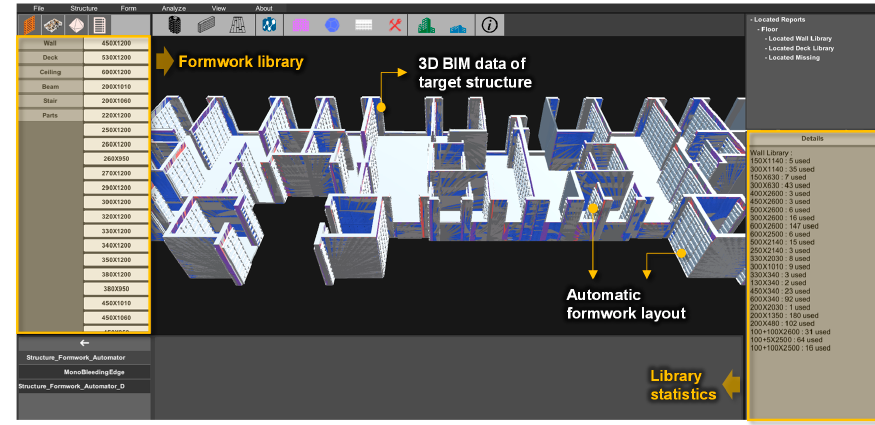
Figure 1. Operational image of the formwork automation design software.